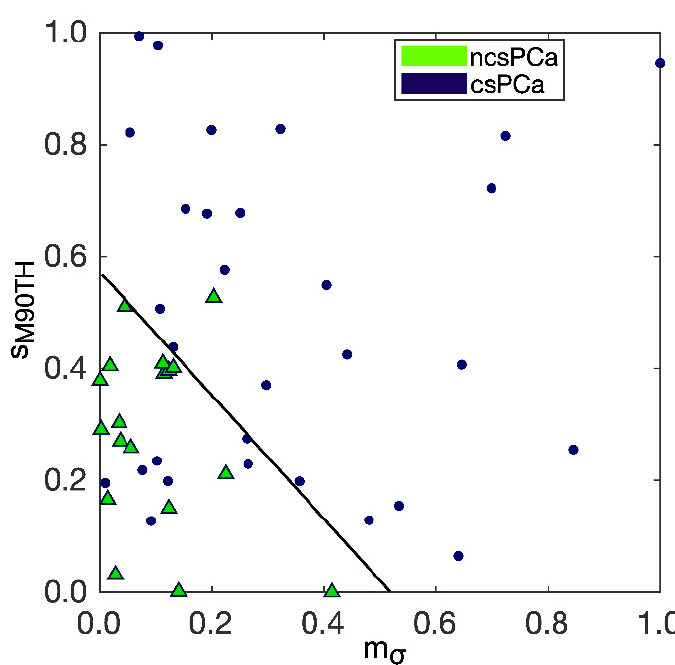
Figure 6. Separation between csPCa and ncsPCa performed by the trained SVM classifier referring to DWI b2000 , with the separation hyperplane highlighted in black.